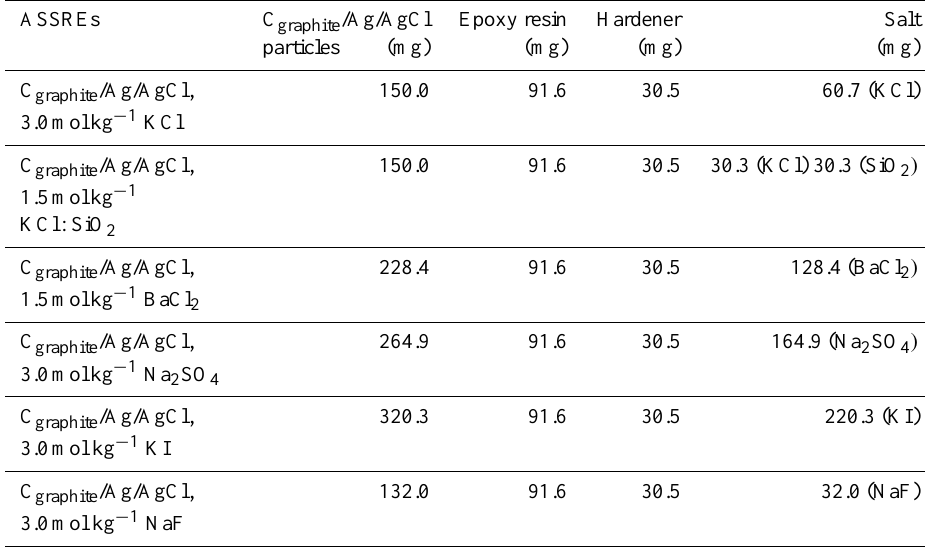
Table 1. Formulations of the all-solid-state reference electrodes (ASSREs). ASSREs C graphite /Ag/AgCl Epoxy resin Hardener Salt